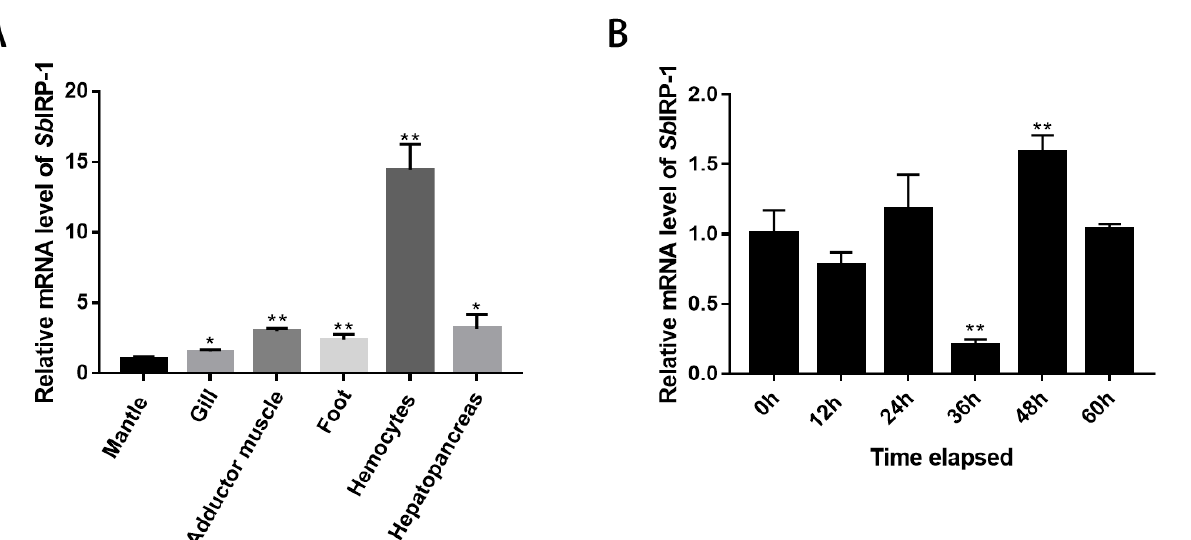
Figure 5. Tissue distribution and expression profile post-OsHV-1 infection of Sb IRP-1. ( A ) Tissues distribution of Sb IRP-1 in healthy ark clams detected by qRT-PCR. The transcript levels in the mantle, gill, adductor muscle, foot, hemocytes and hepatopancreas were normalized to that in the mantle. ( B ) Expression profiles of Sb IRP-1 mRNA after OsHV-1 infection in the hemocytes. Vertical bars represent the means ± SD ( n = 3). Asterisks indicate significant differences: ** p < 0.01, * p < 0.05. Sb IRP-1 mRNA expression level was strongly affected by OsHV-1 infection. The mRNA expression level of Sb IRP-1 genes in hemocytes significantly increased (1.58 ± 0.12-fold, p <